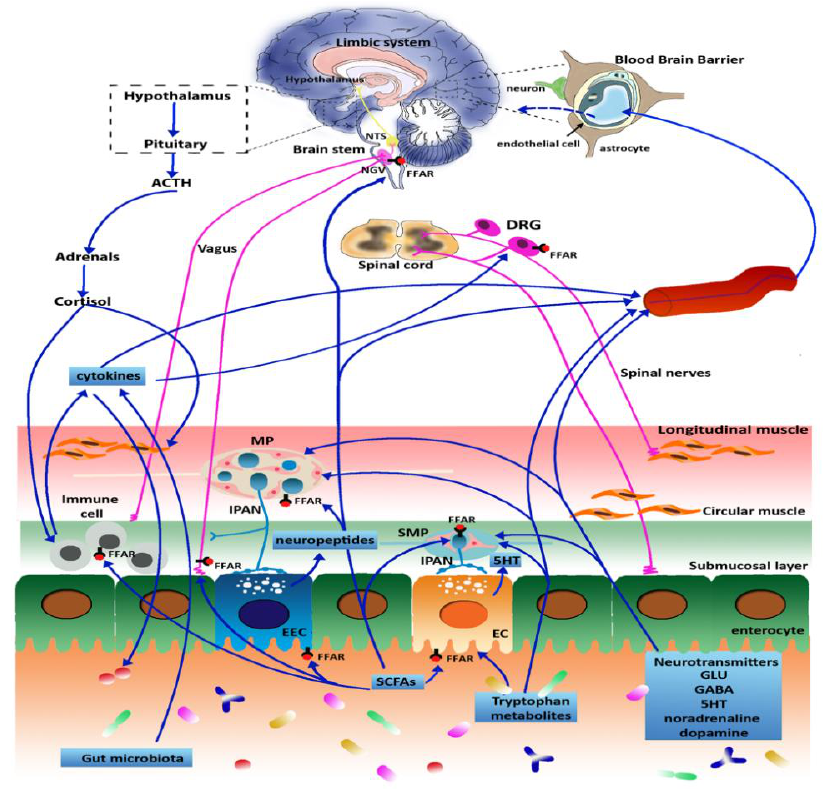
Figure 1. Schematic representation of the microbiota-gut-brain axis. The gut microbiota signals to the enteric nervous system (ENS) and to the CNS via different pathways, including endocrine, immune, metabolic and neuronal pathways as described throughout the text. In physiological conditions, the blood-brain barrier (BBB) allows the access of tryptophan metabolites and SCFAs into the CNS but blocks the passage of circulating neurotransmitters except for gamma aminobutyric acid (GABA). However, in pathological conditions, the disruption of BBB leads to an increased amount of circulating neurotransmitters in the brain.